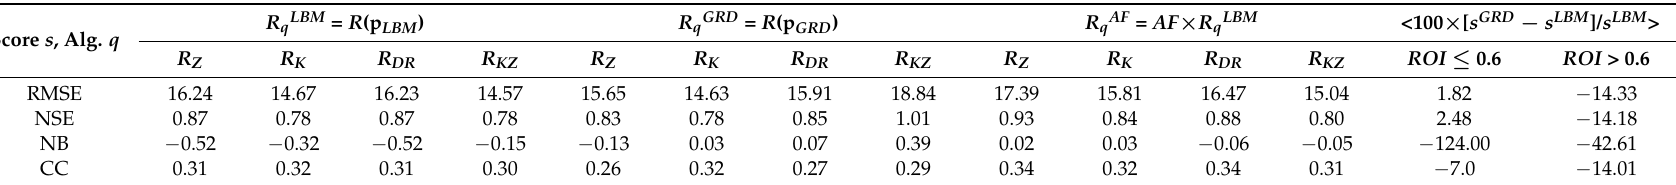
Table 3. As in Table 2 but for 15 October 2012.